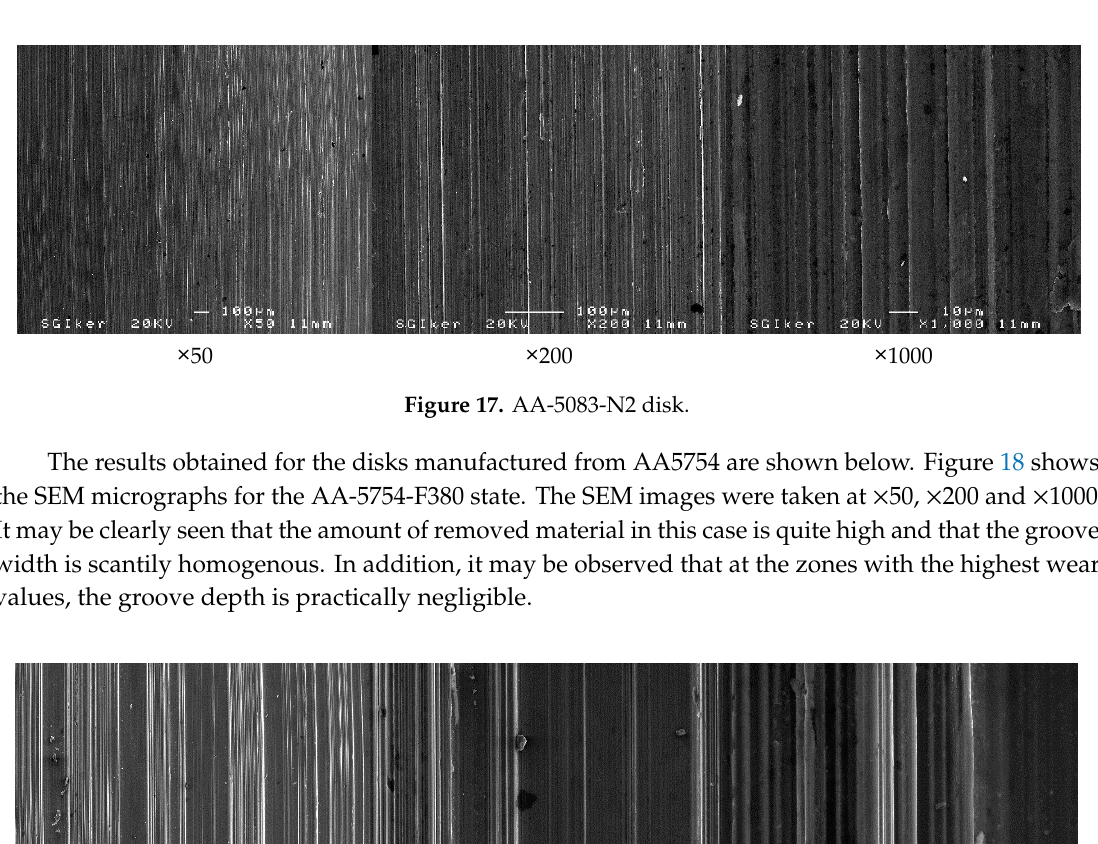
Figure 16. AA ‐ 5083 ‐ N0 disk. Figure 16. AA-5083-N0 disk.